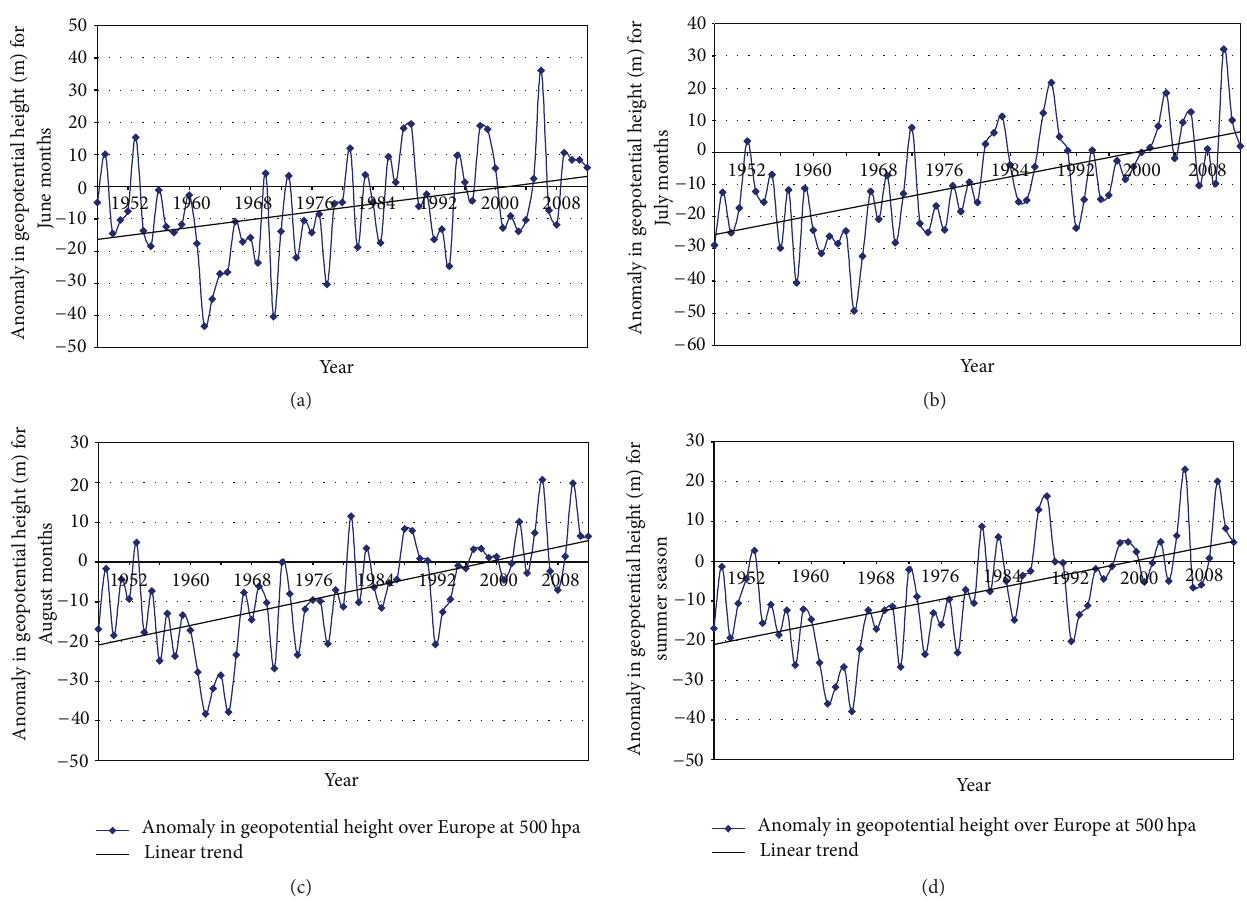
Figure 1: Time series of geopotential anomalies (m) at 500 hpa level over Europe through summer seasons of the period 1948–2012. (a) June months, (b) July months, (c) August months, and (d) summer